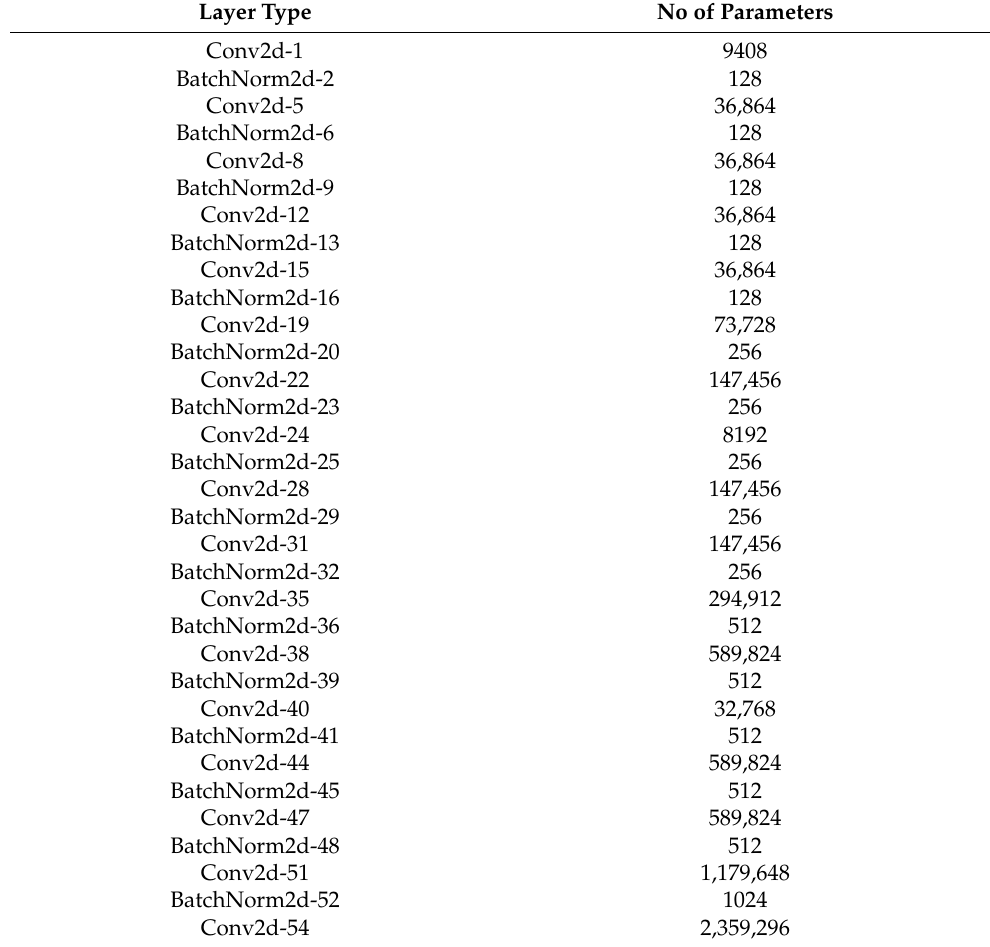
Table 3. The modified ResNet18 Architecture for AD Classification.